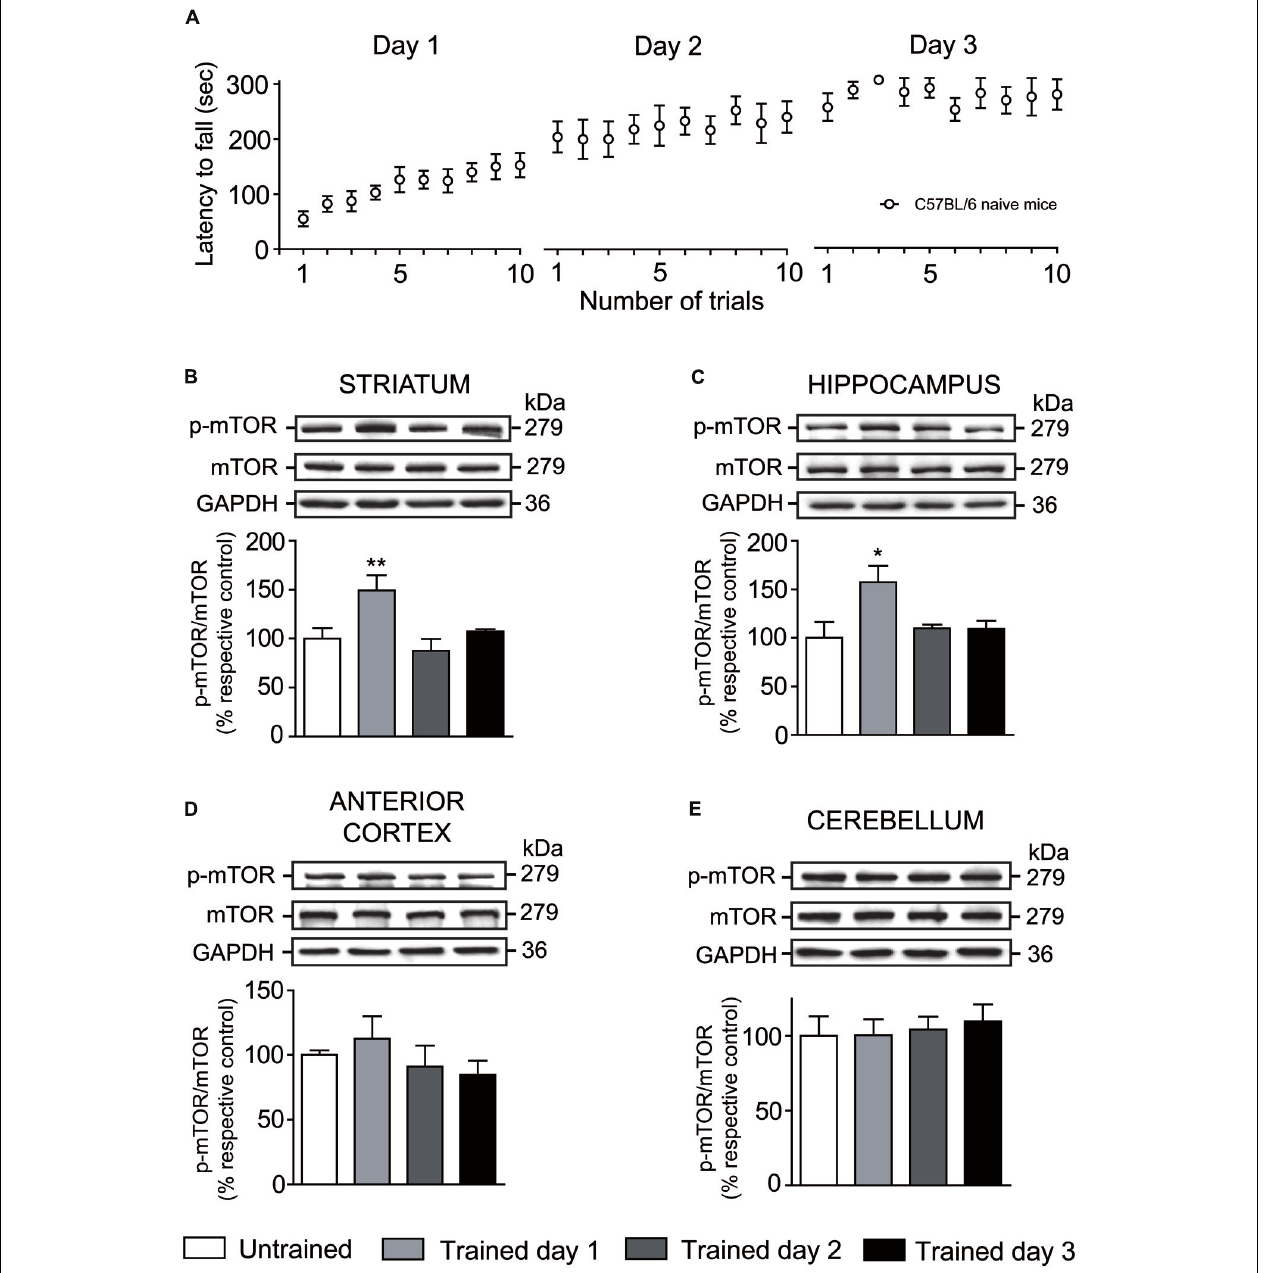
days 1, 2, and 3. The data, expressed relative to levels of total mTOR, represent the mean of relative optical density of phosphorylated mTOR (expressed as a percentage of control values) ± S.E.M, n = 3 or 4; triplicate experiments for each mouse/group. ** P < 0.01 and * P < 0.05 vs. respective untrained